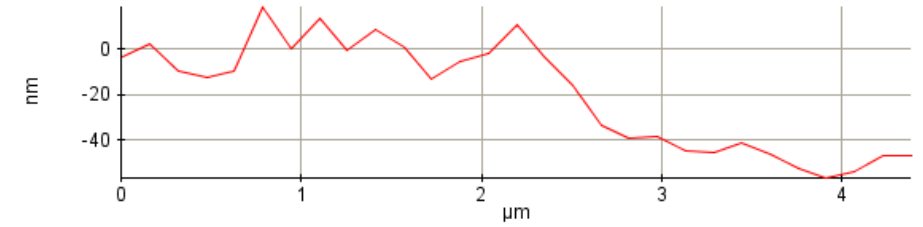
Figure 1. Line profile of 50 nm CoPt thin film prepared at pH = 5.5 in the presence of saccharin.